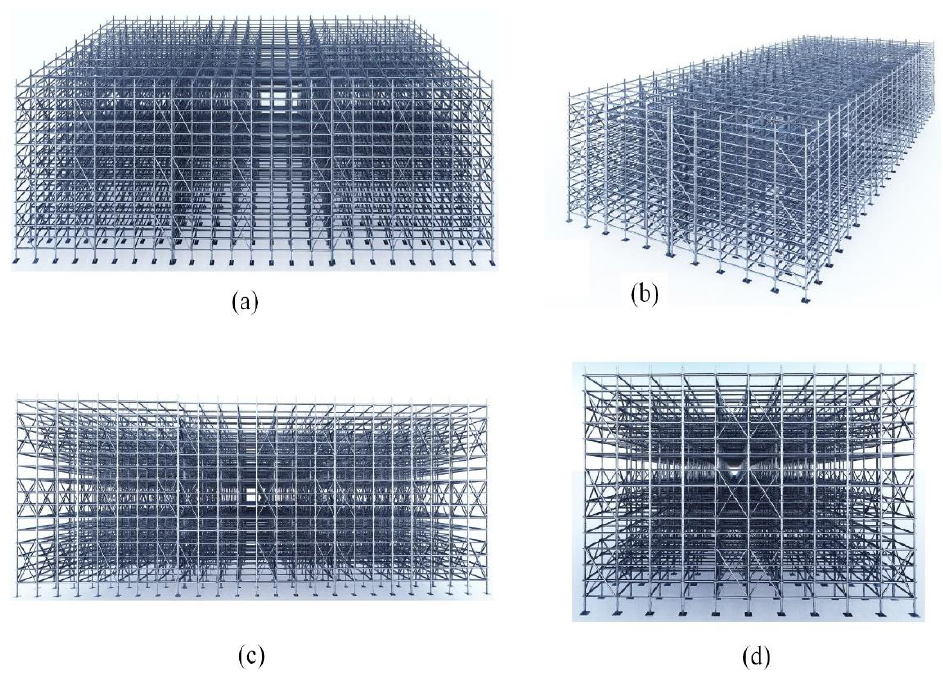
Figure 11. The generated photorealistic 3D model of the high formwork structure using the proposed method ( a ) the full view of the model, ( b ) the top view, ( c ) the front view, and ( d ) the side view.